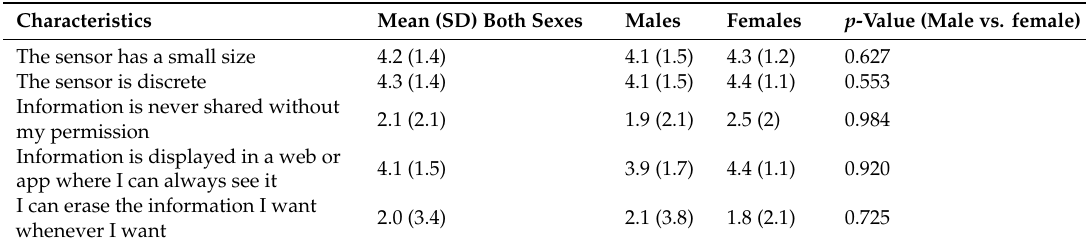
Table 2. Features associated with enhanced acceptability (rated from 0 (lowest) to 5 (highest)).